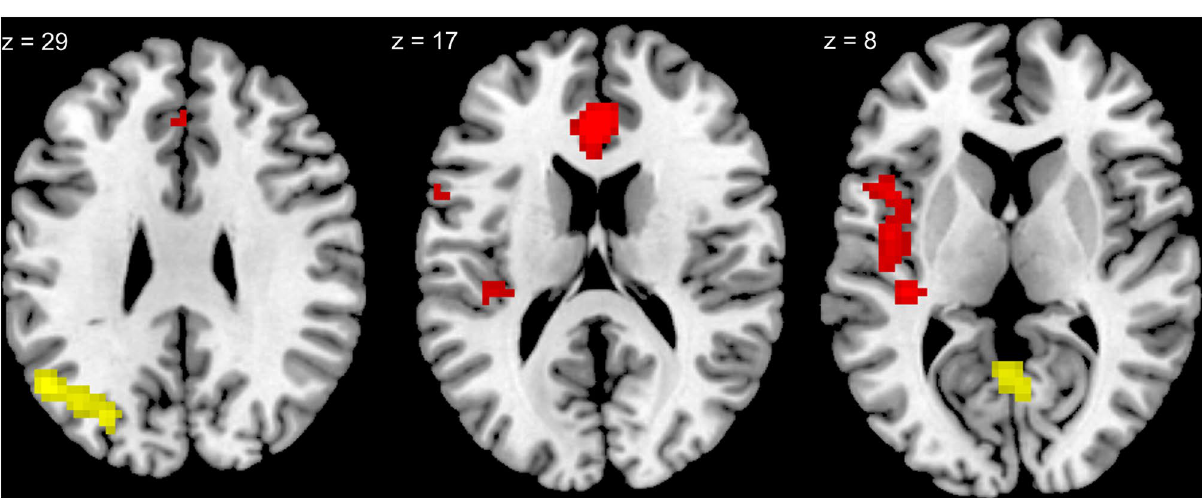
Figure 1. Activation clusters positively associated with verbal hallucination proneness score during correct recognitions (yellow) and false recognitions (red) of low-frequency words, while controlling for visual imagery score, sex, verbal IQ, and Pr-global. The slices depicting MNI coordinates derive from peak activations for the low-frequency word contrasts reported in Tables 1 and